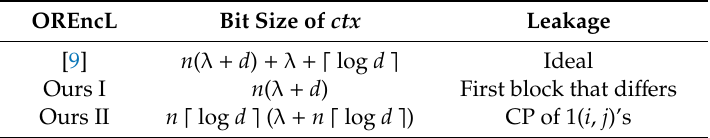
Table 2. Comparison of our ORE for exponentially-sized domains (OREncL) and the existing